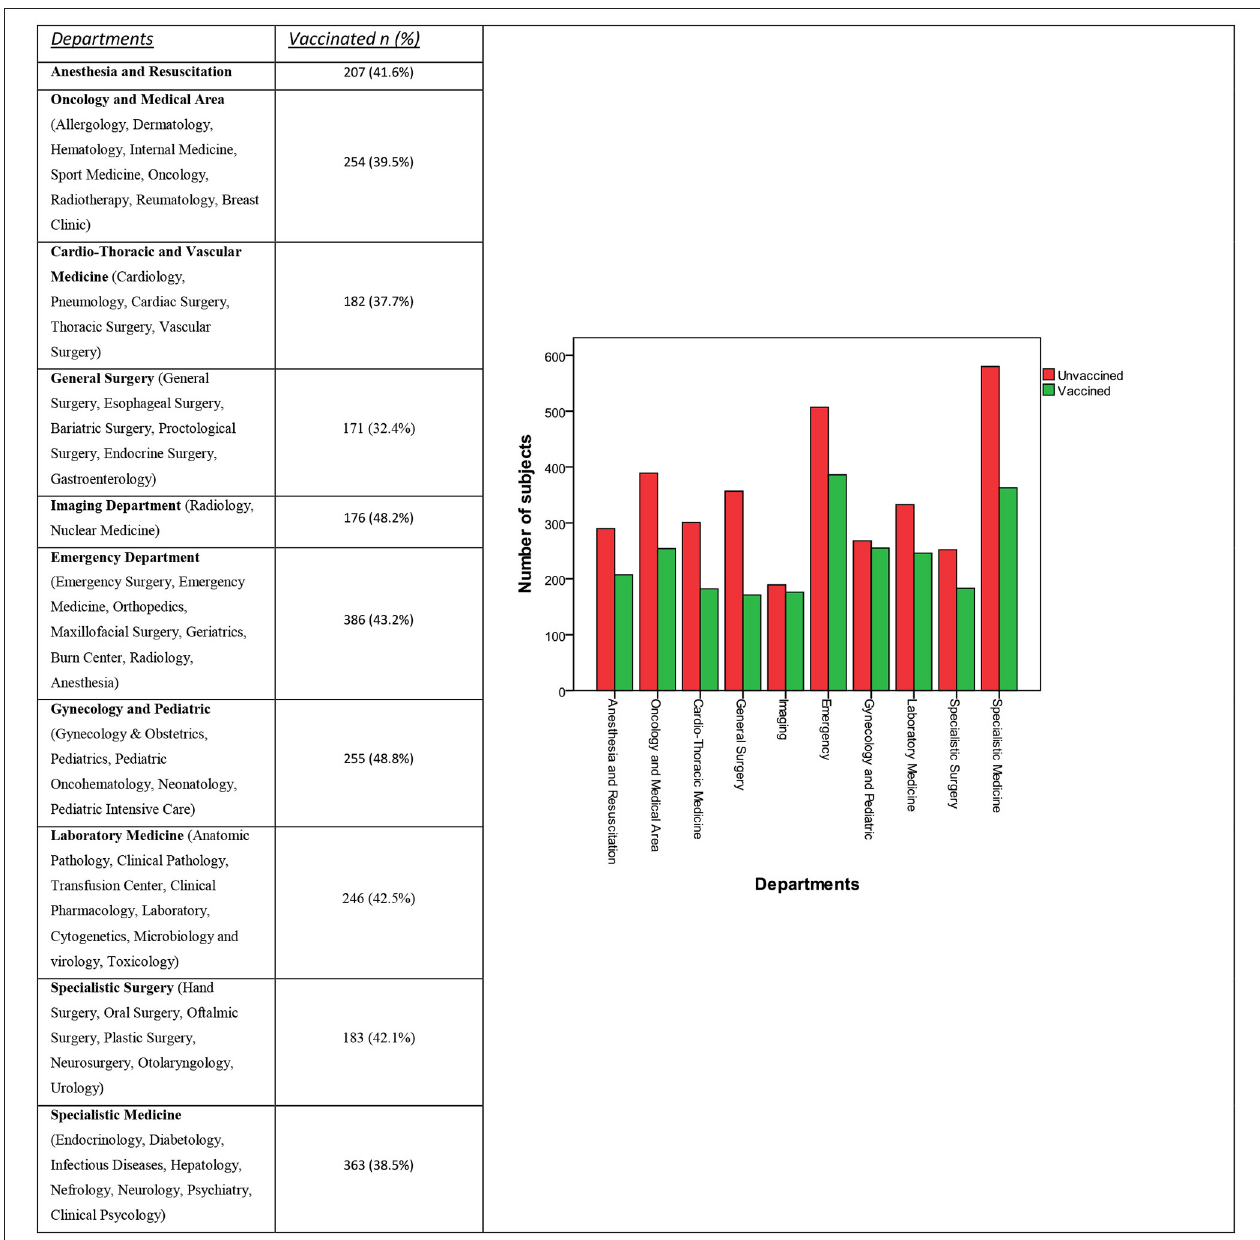
FIGURE 1 | Distribution of vaccine to unvaccinated subjects in different departments, in number and